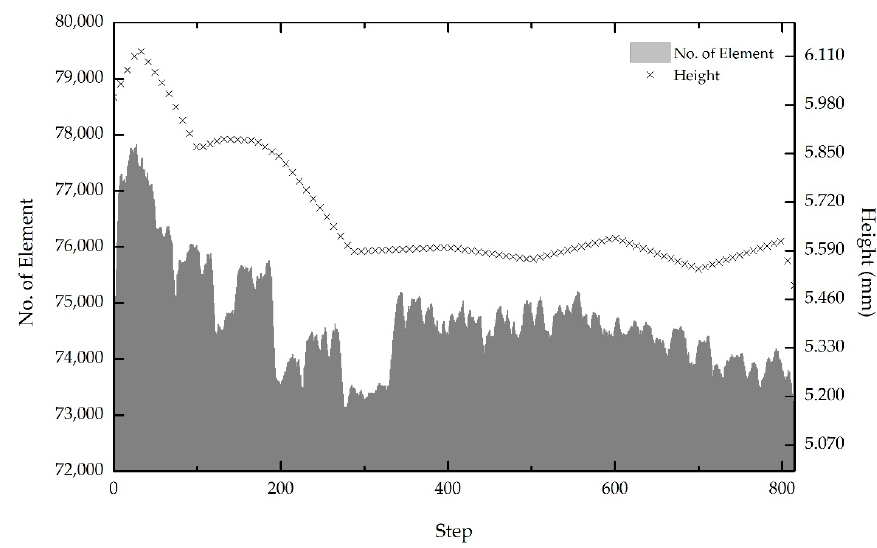
Figure 13. Workpiece height reduction throughout the hot press forging simulation.